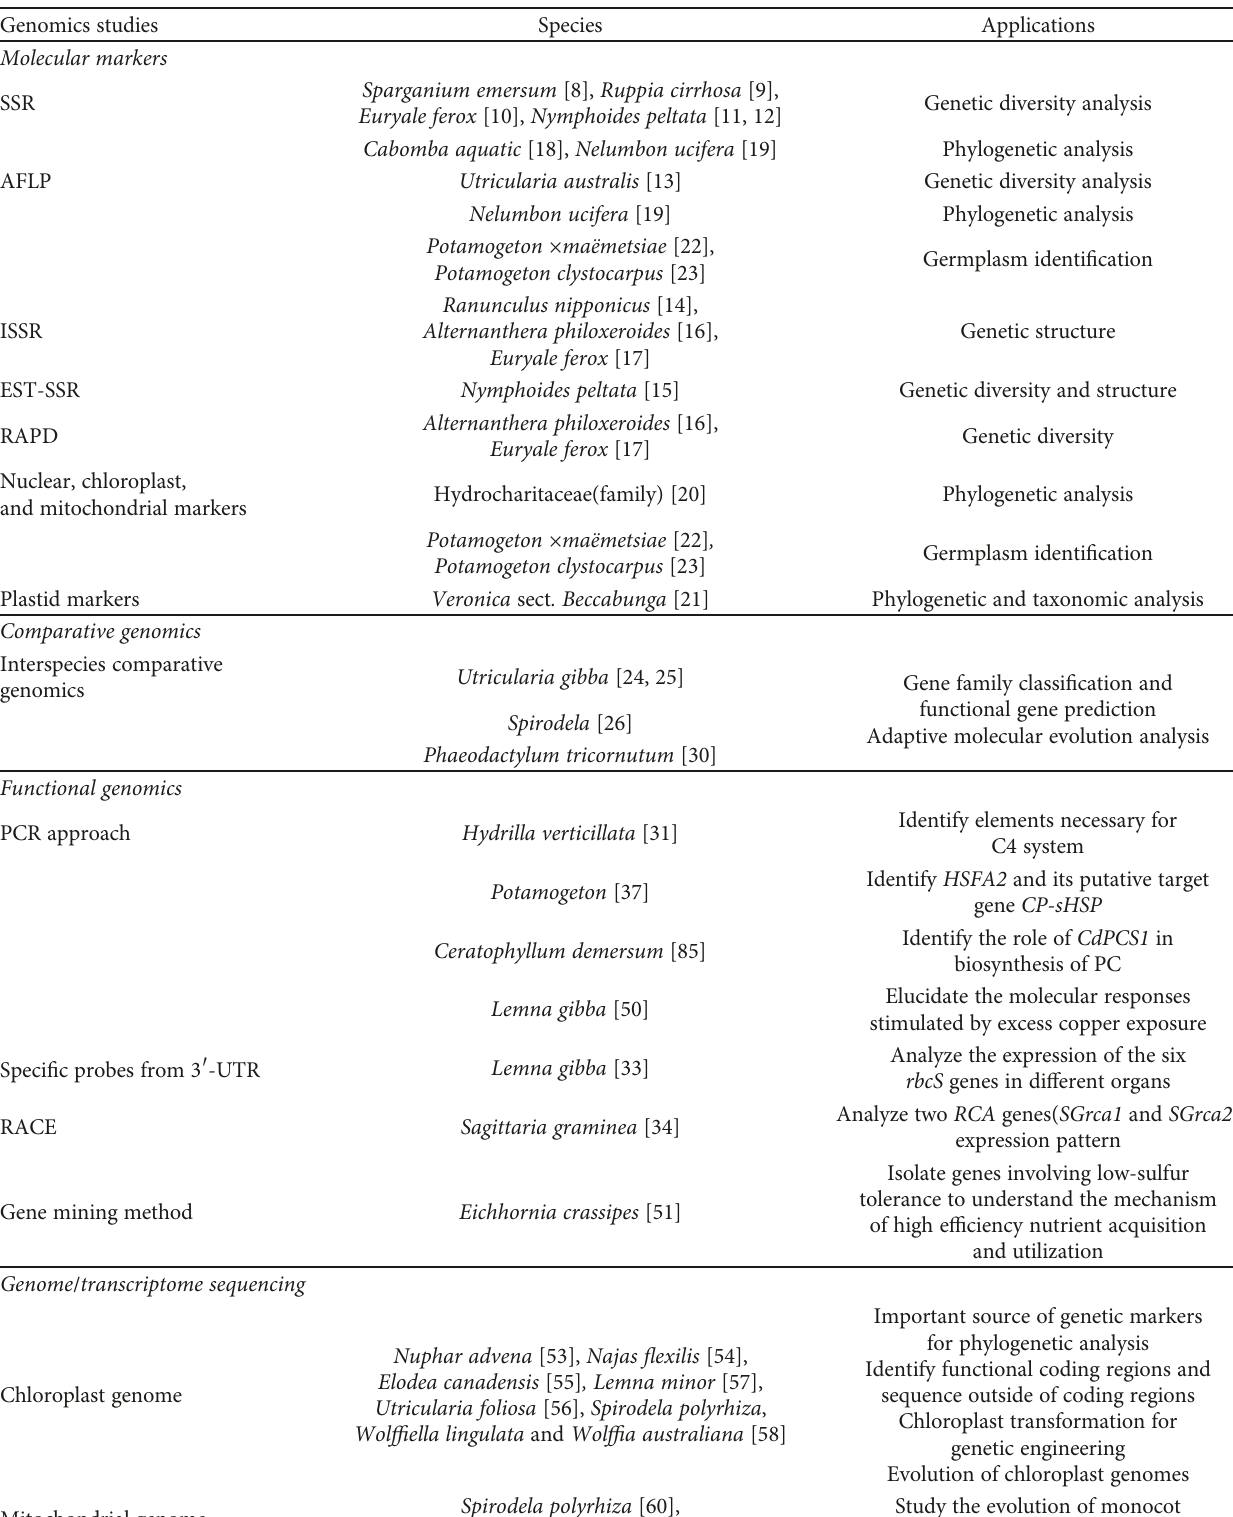
Table 1: Summary of the genomics studies and technologies correlated to aquatic plant species discussed in the